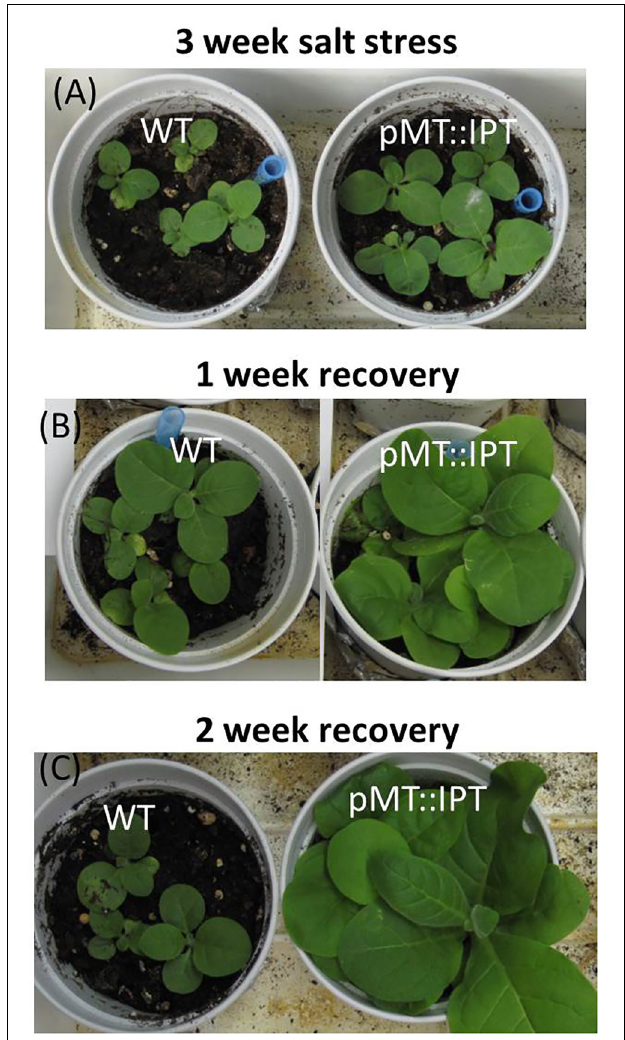
FIGURE 5 | Recovery of pMT:IPT compared to WT tobacco plants after salinity stress. Three week old tobacco plants watered with NaCl solution (100 and then 200 mM) for 3 weeks then transferred to normal watering for two additional weeks. Plants after: (A) salinity stress; (B) 1 week recovery; (C) 2 weeks of recovery. The photo represents one of three independent experiments showing similar